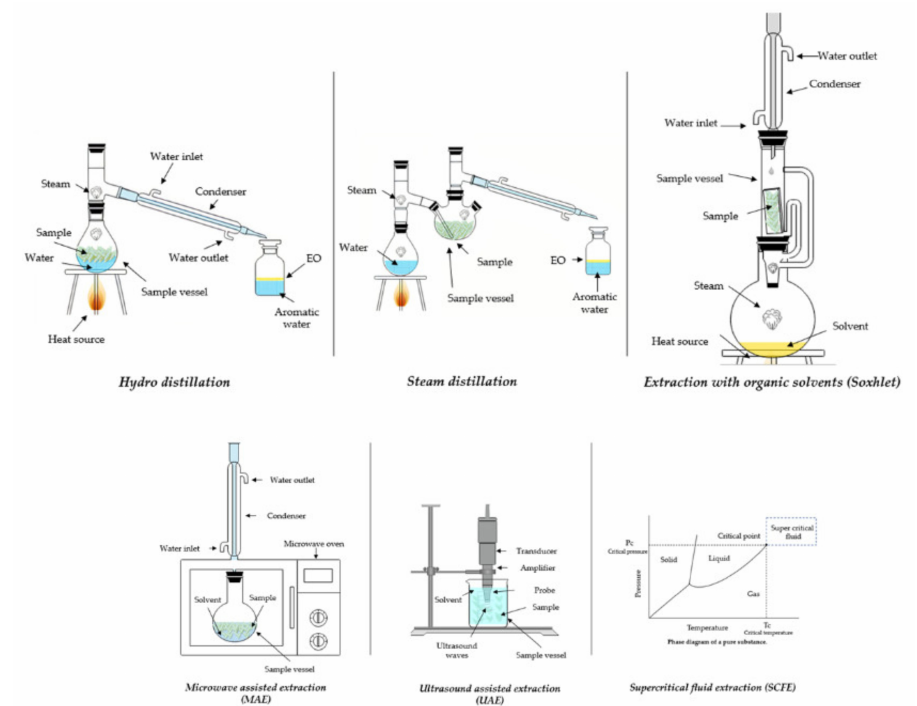
Figure 2. Extraction technologies applied in the recovery of secondary metabolites of Mexican oregano species [MAE: Microwave-assisted extraction; UAE: Ultrasound-assisted extraction; SCFE: Supercritical fluid